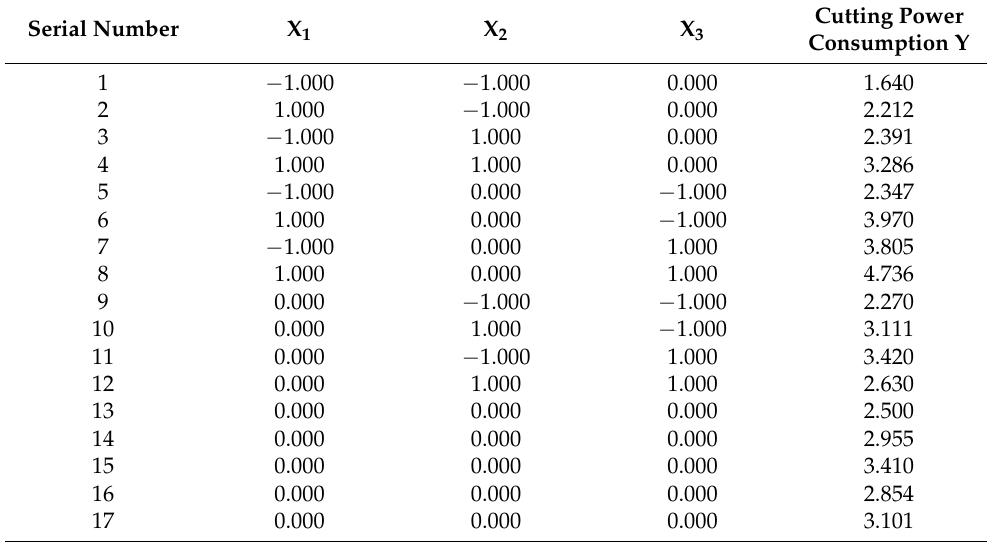
Table 4. Design and results of cutting simulation experiment.